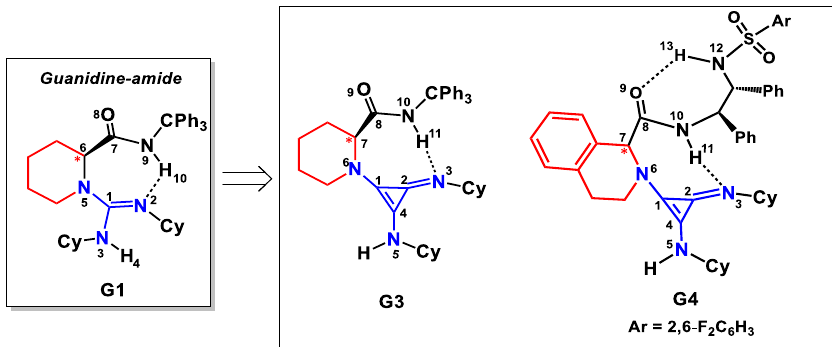
Scheme 4. New catalysts G3 and